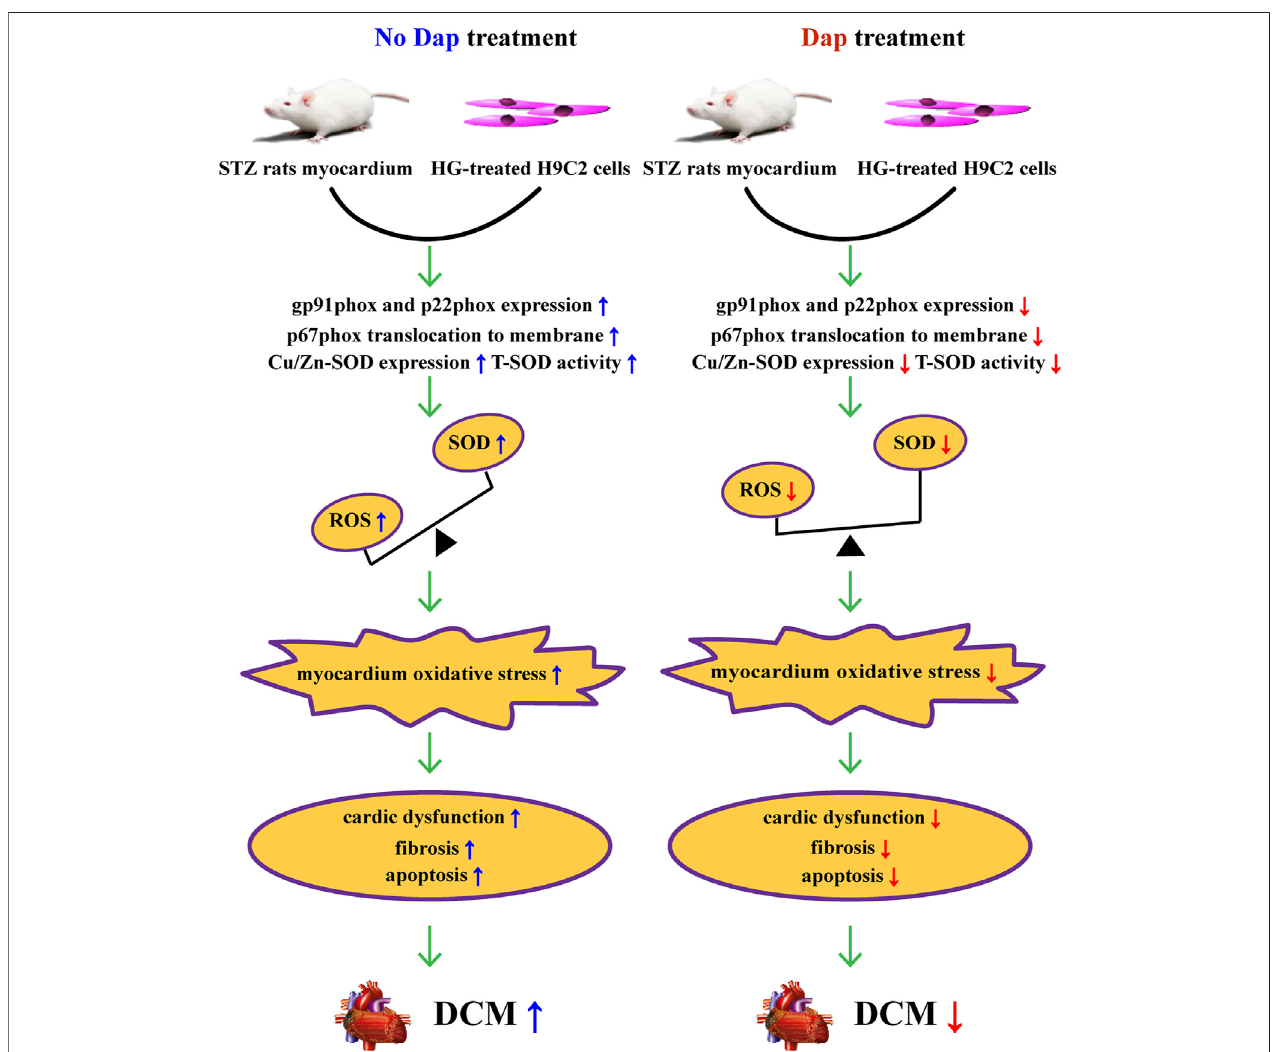
FIGURE 7 | Summary of the mechanisms of Dap that suppress high glucose-induced oxidative stress in vivo and in vitro .